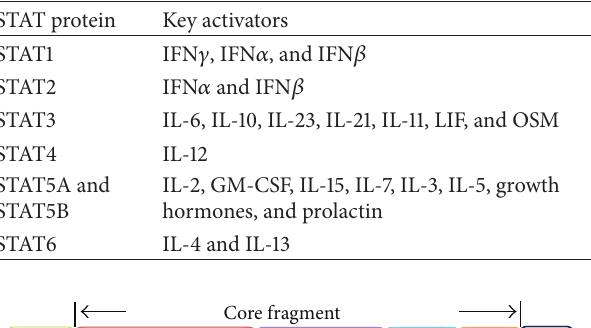
Table 1: Activators of STAT family proteins (adapted from Yu et al., 2009 [9]).